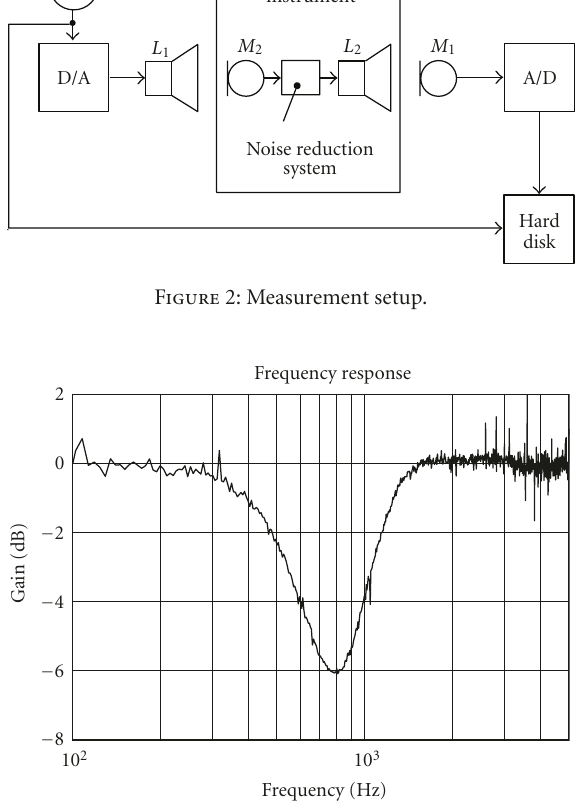
Figure 3: Measured frequency response of a noise reduction system that is stimulated for attenuating one